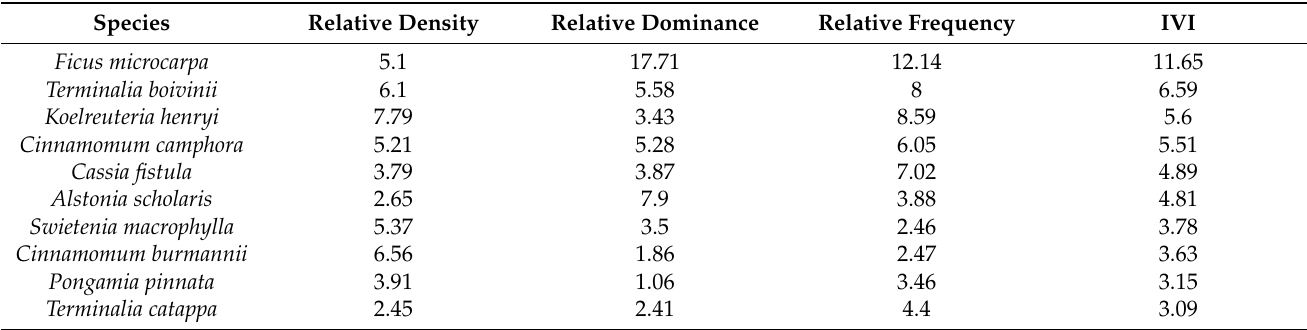
Table 4. Importance Value Index (IVI) of woody plants in the sample plots.